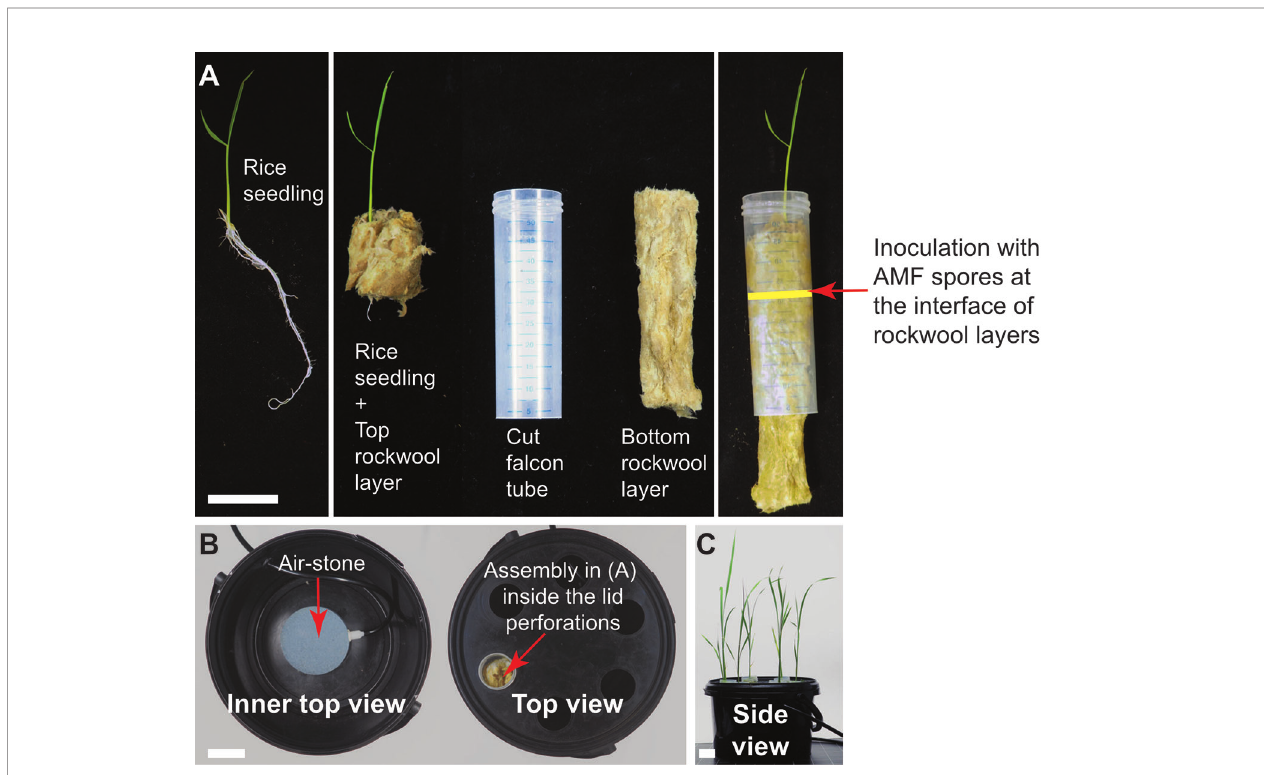
FIGURE 5 | Falcon-wick hydroponics for arbuscular mycorrhiza (AM) of bigger plants such as rice. (A) Twelve-day old rice seedling prepared for inoculation with AM fungi (AMF) in hydroponics. Arrow indicates the interface of the two rockwool layers where the AMF spores are placed. (B) Top view of the hydroponics set-up in the black bucket. (C) Rice growing in hydroponics at 3 wpi. All scale bars: 3